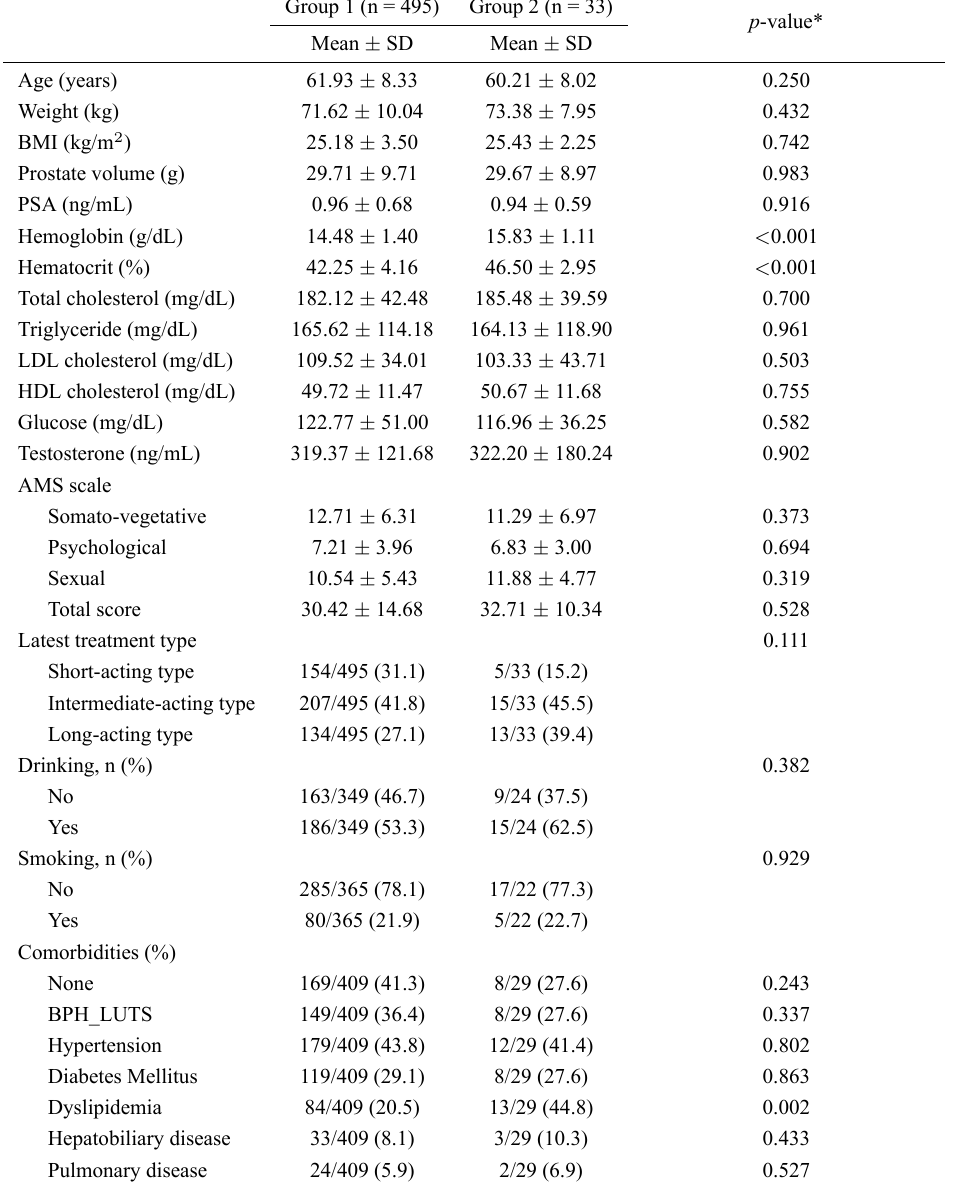
Table 5. Comparison of baseline medical and demographic characteristics between the hematocrit (hct) elevation ( > 52%; Group 2) and the non-hct elevation group (Group 1) during testosterone